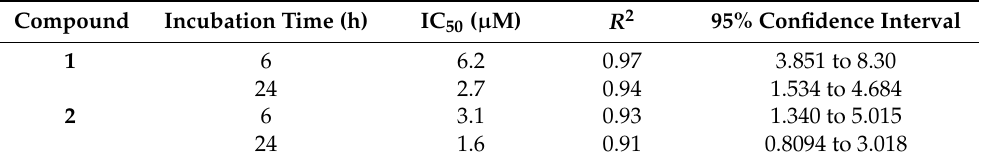
Table 3. IC 50 ( µ M) of gold compounds in SH-SY5Y cells determined with a 3-(4,5-dimethyl